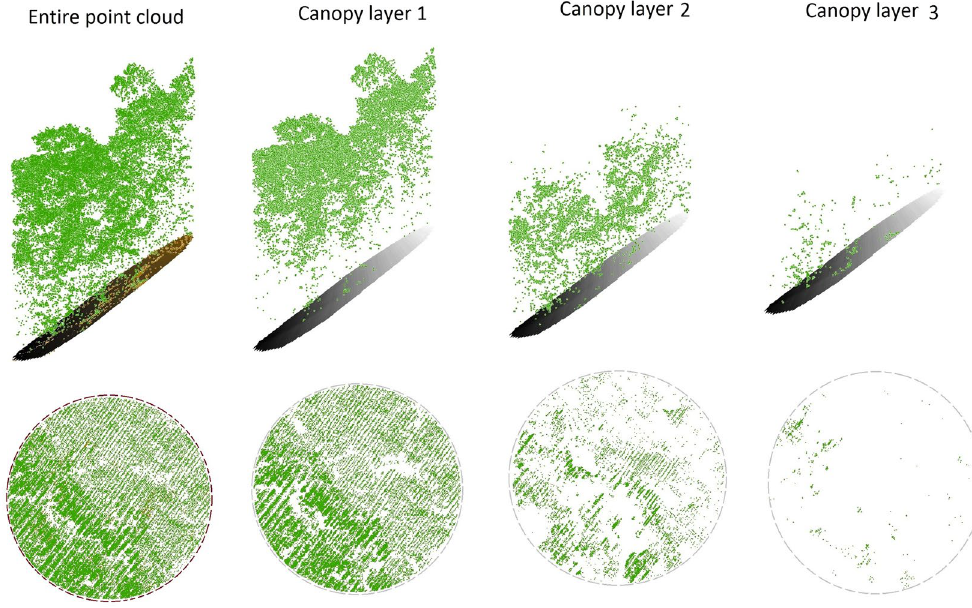
Figure 1. Stratification of forest LiDAR point cloud to its constituting canopy layers. Each image in the bottom row shows the aerial view of the three dimensional image right above